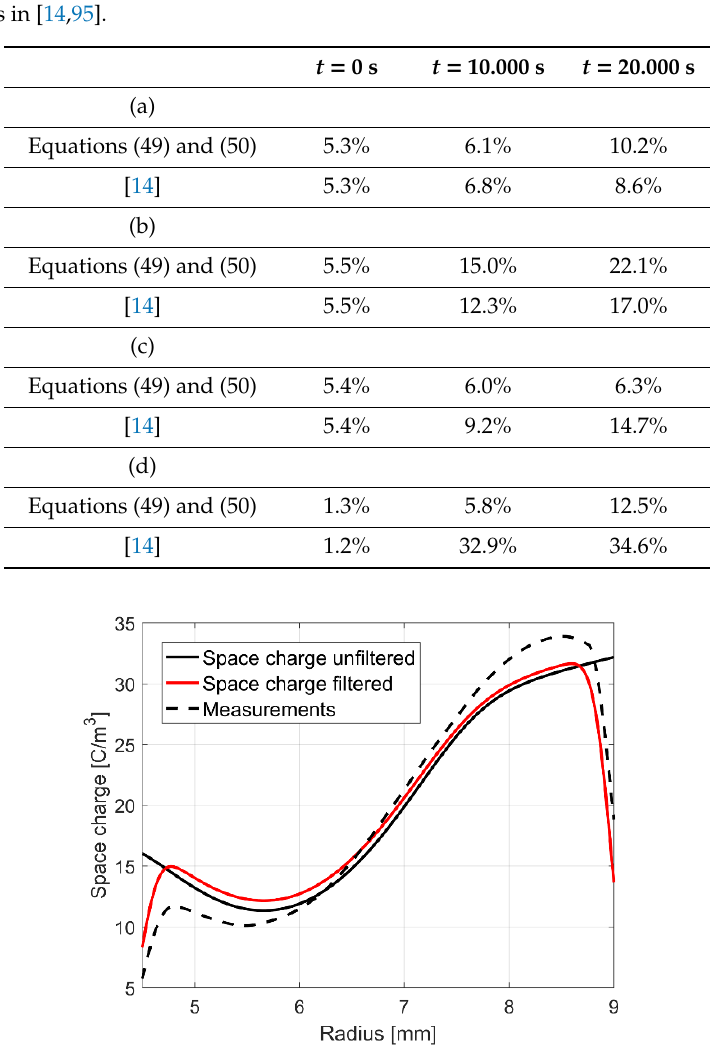
Figure 20. Corresponding electric field of the filtered and unfiltered simulation results in Figure 19l, compared with measurements at the moment t ≈ 20,000 s. [95].